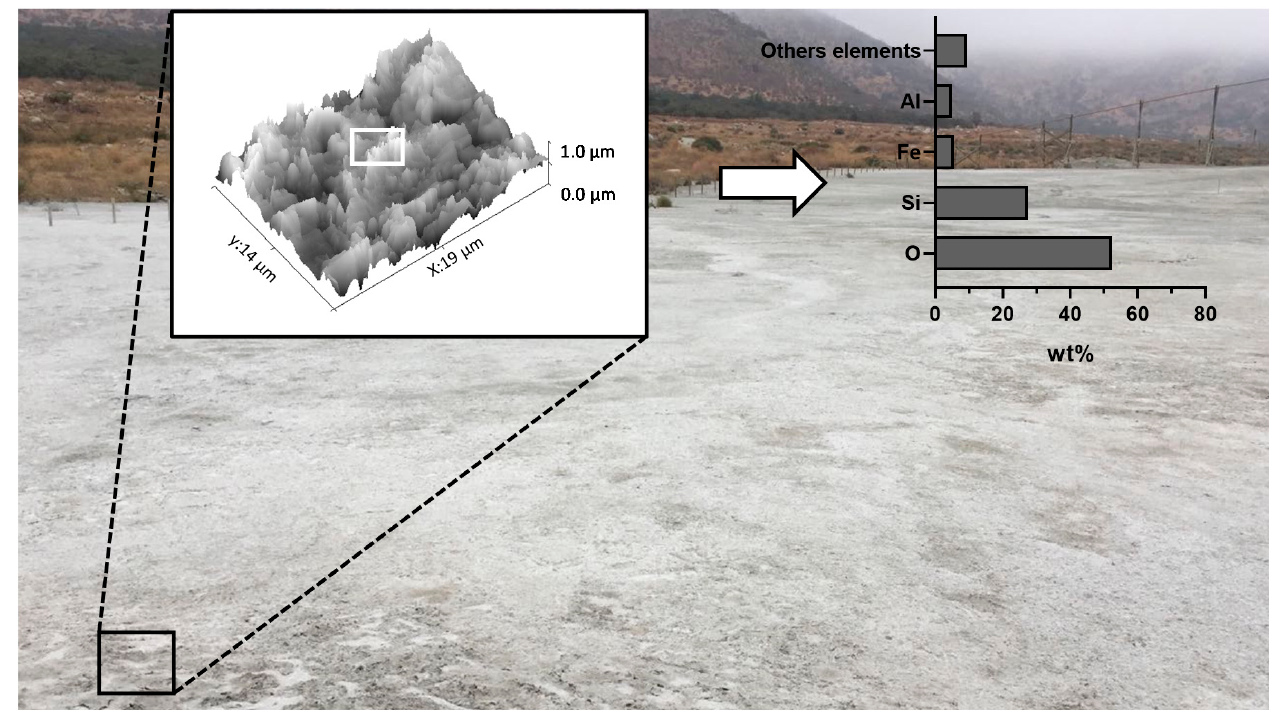
Figure A2. SEM-EDS analysis of paste tailings. Representative 3-D SEM image of T2 sample is shown [36].